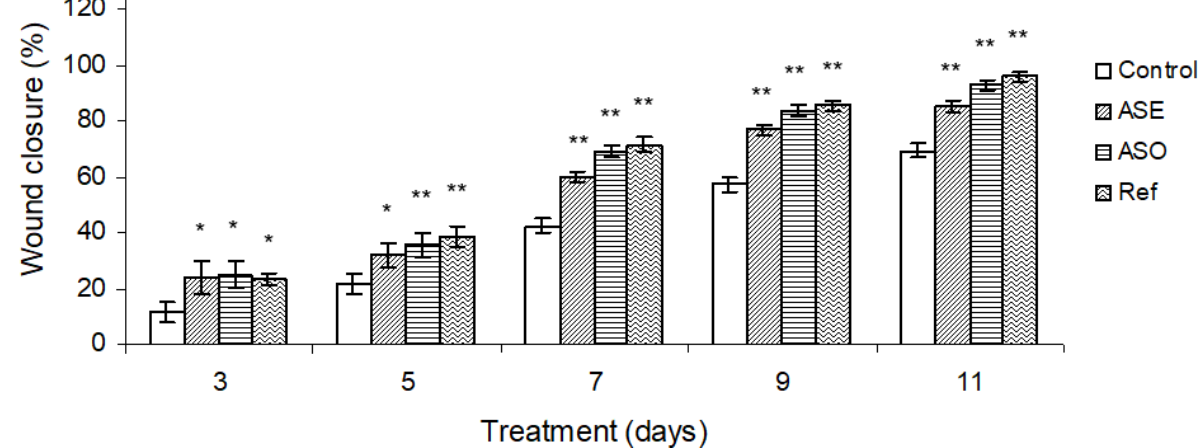
Figure 2. Effects of Allium subhirsutum L. extract (ASE), Allium subhirsutum L. oil and the reference drug “Cytolcentella ® ” on the percentage of wound closure in control and treated rats. Data represent the mean ± SEM for six rats. Statistically significant variations are compared as follows: ASE, ASO and Ref treated groups compared to control group. * and ** indicate significant differences when p < 0.05 and p < 0.01, respectively.